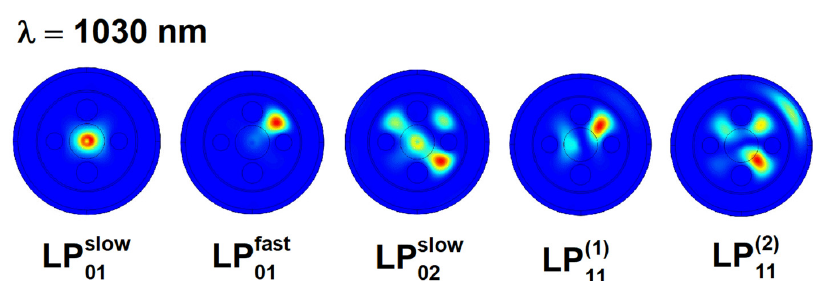
Figure 2. Calculated electric field intensity distribution for the modes (with power in the core more than 10%) of the quasi-BF structure bent with radius of 0.5 m.